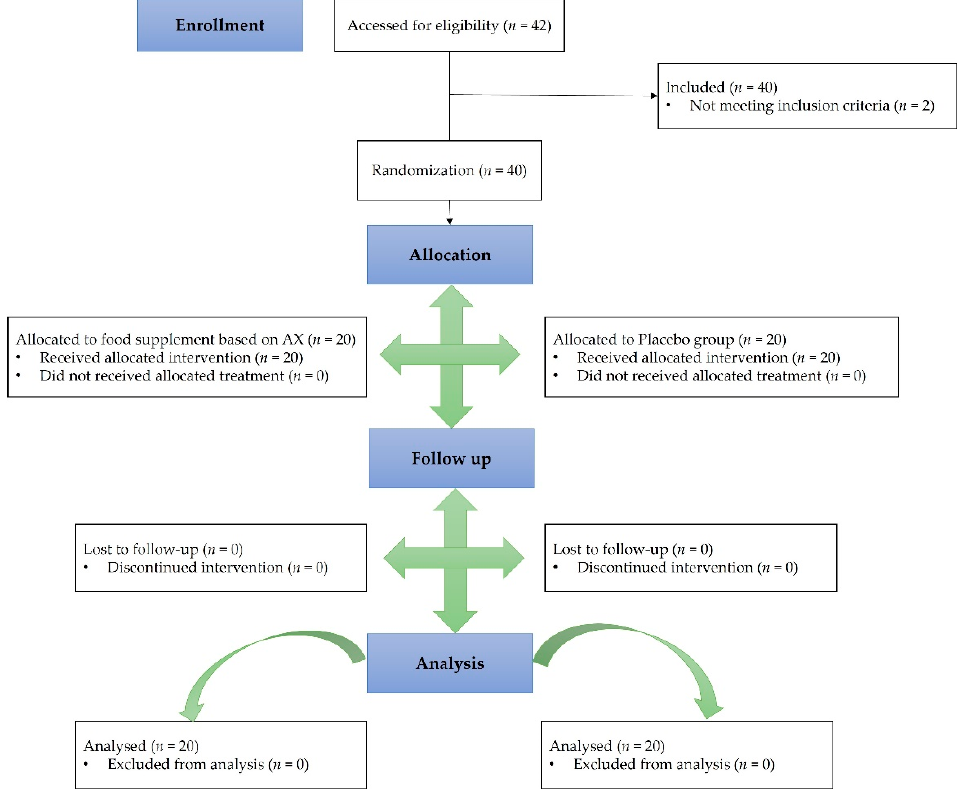
Figure 2. CONSORT Flow diagram. Table 3. Characteristics of the study population: demographic and clinical data at baseline